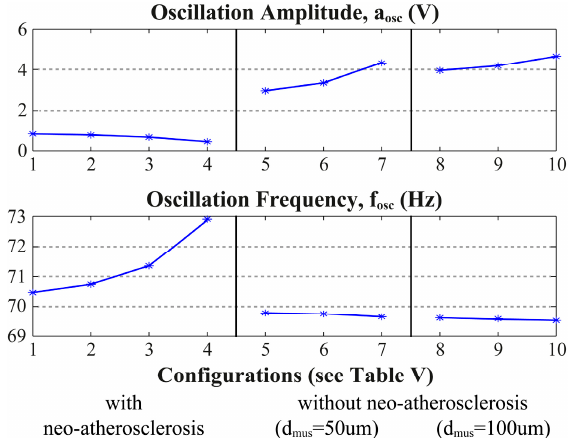
Figure 8. OBT auto-calibration circuit amplitude and frequency for the histological configurations in Table 5, measured at node V out2 of Figure 1.